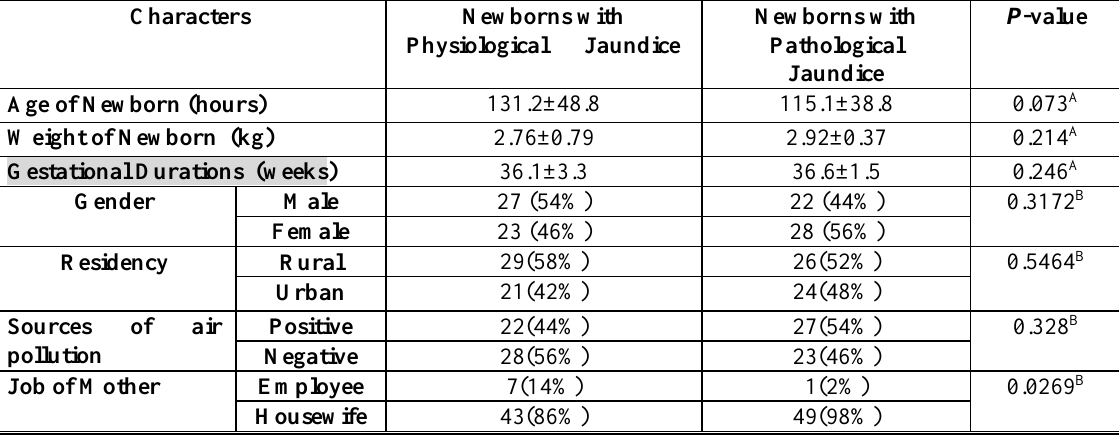
Table 2. Demographical information of newborns with physiological jaundice and pathological jaundice.